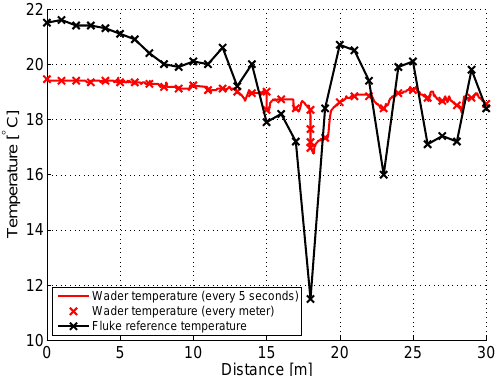
Figure 5. Results of the field evaluation. The location of the boil can be clearly seen in the measurements by the reference thermometer (Fluke) and the waders. The waders show a less pronounced re- sponse to the influx of cold water than the